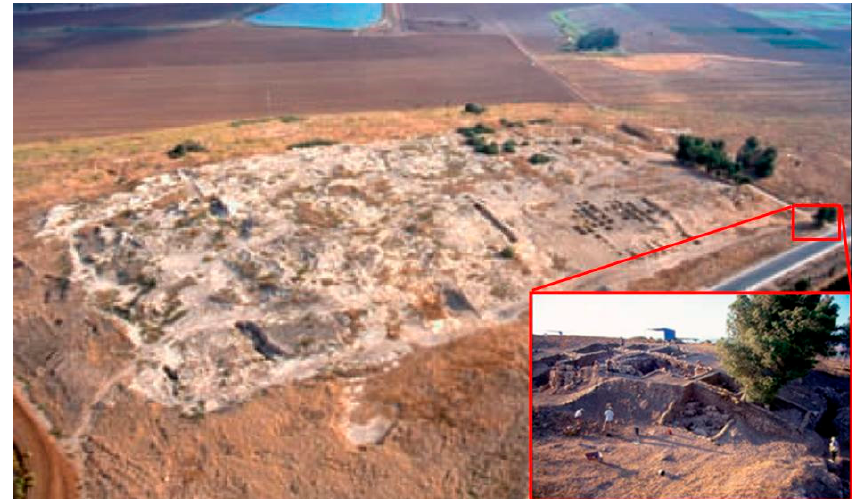
Figure 1. Aerial photograph of Tel Jezreel, evidencing the rectangular shape of the site, which originally had four towers at the four corners. The zoom in the right-bottom inset shows the ruins of one of the four towers (The photographs shown in Figure 1 have been published in D. Ussishkin. 2011 On